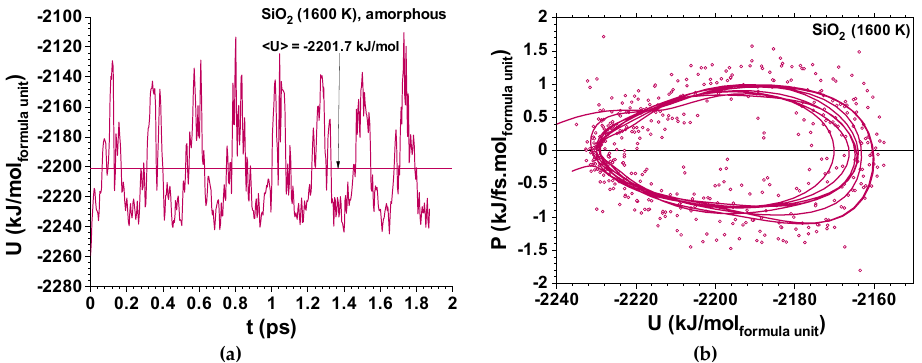
Figure 8. Ab Initio Molecular Dynamics for the amorphous Si 3 O 6 showing noise and a quasi-periodic structure; ( a ) total energy vs time for SiO 2 at 1600 K; the calculated specific heat is C v’ = 0.826 kJ/kg K; no damping is observed; ( b ) phase portrait of SiO 2 for power vs potential energy showing one energy well and almost no anharmonicity. The difference between the two energy states is Δ U ≈ 0.62 eV and K B T = 0.129 eV. Almost no focus (equilibrium energy) displacement is observed. Note that simulations not shown here demonstrate that for a larger box such as that containing Si 108 O 216 , deco- herence is achieved immediately even at room temperature.